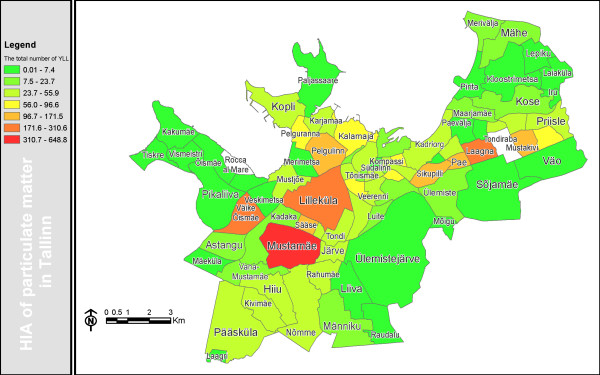
The total number of YLL due to PM2.5 pollution in Tallinn.